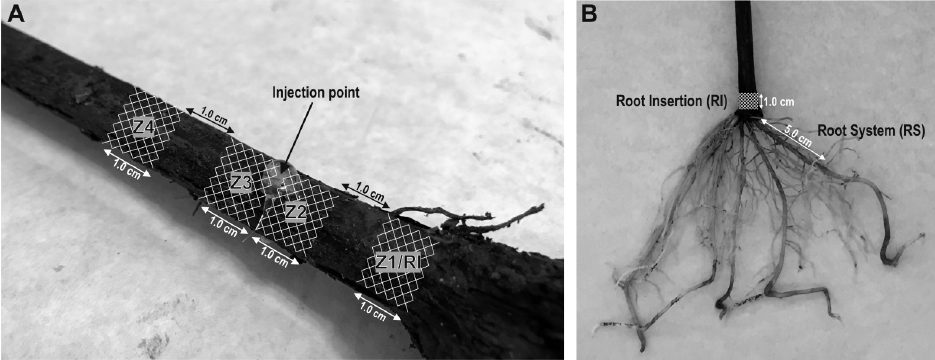
Fig 1. Scheme of inoculation of grapevine plants and areas analysed. Image of (A) the inoculation point in the rootstock of plants treated by injection, as well as the four 1.0 cm cylinders (Z1/RI, Z2, Z3 and Z4) analysed once the plants were uprooted, and (B) the zones defined as root insertion point (RI) and root system (RS) also analysed in plants inoculated by immersion in a cell suspension. Note that Z1/RI and RI zones in plants inoculated by injection or immersion are equivalent for analytical